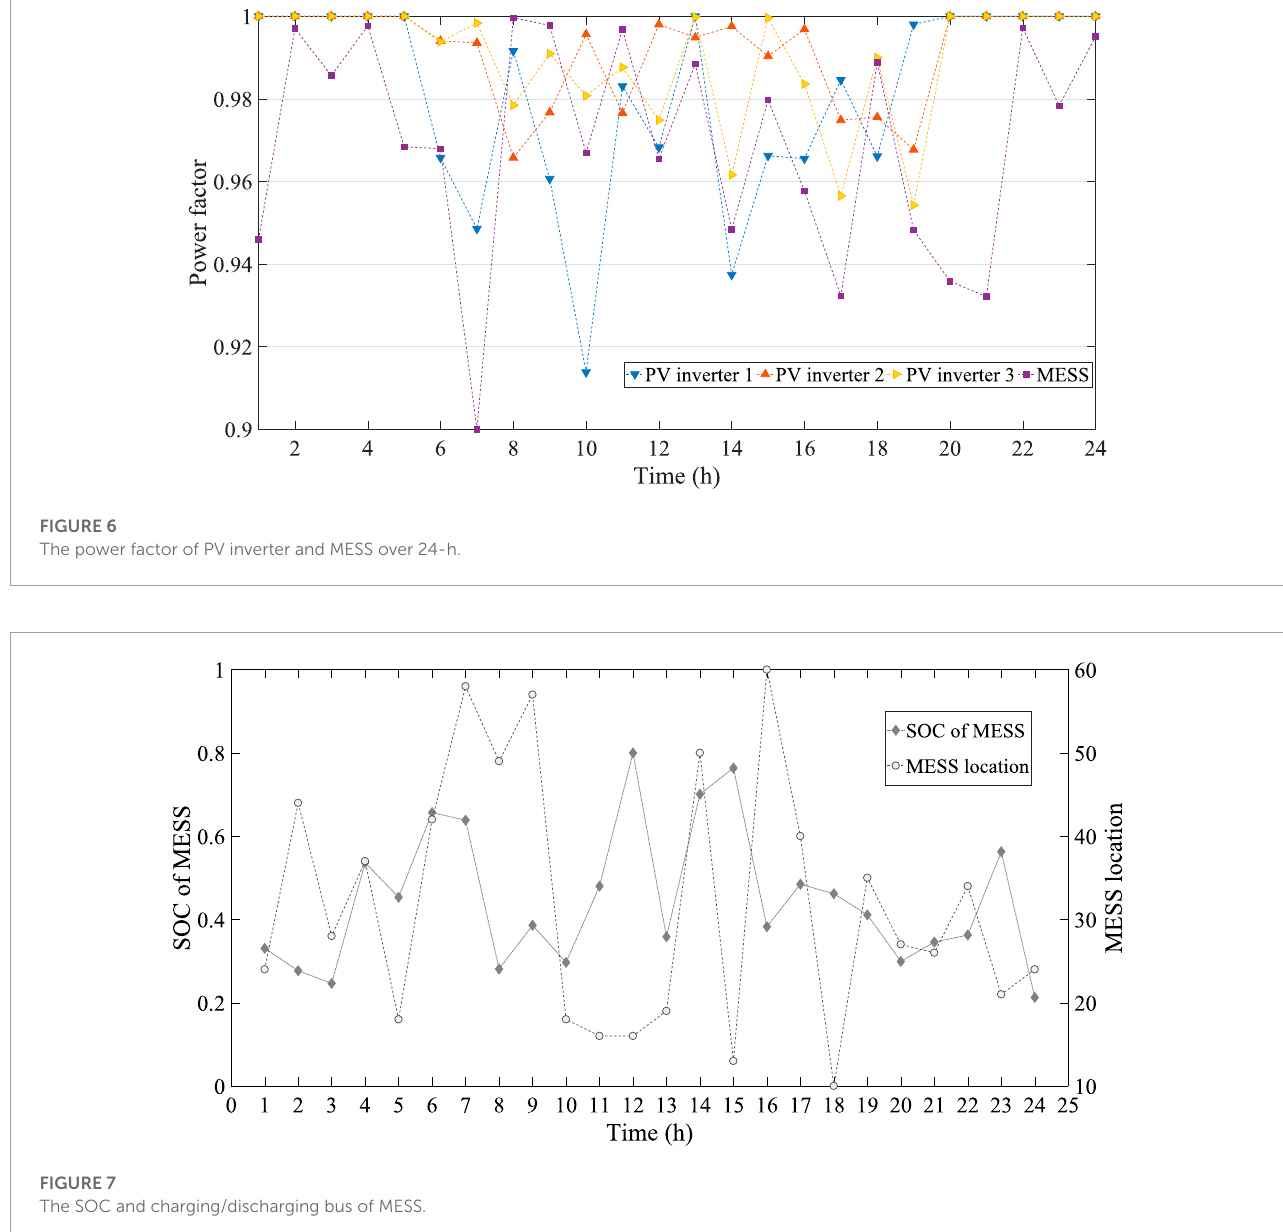
Equation 21a describes the MESS available energy at the start As for MESS, if the allowed power factor is C and end time which should be equal, where SOE ( 0 ) and SOE ( T ) are operating space is represented as: respectively the state of energy (SOE) at start and end time; Eq. 21b denotes the state of charge (SOC) of MESS, SOC ( t ) denotes the state of the charge at time t , E is the capacity of MESS, and SOC MESS max and SOC denote the maximum and minimum SOC, respectively; min Eq. 21c is employed to determine the capacity of MESS, where SOE max and SOE indicate the maximum and minimum SOE, respectively; min Eq. 21d denotes the relationship between charging/discharging power and SOE during time t , where η ch / dch and P ch / dch , t are respectively MESS MESS the charging/discharging efficiency and power; Eq. 21e represents the maximum power constraint, where P max denotes the maximum MESS charging/discharging power of MESS. where Q ch / dch , t represents reactive power of MESS during time t MESS